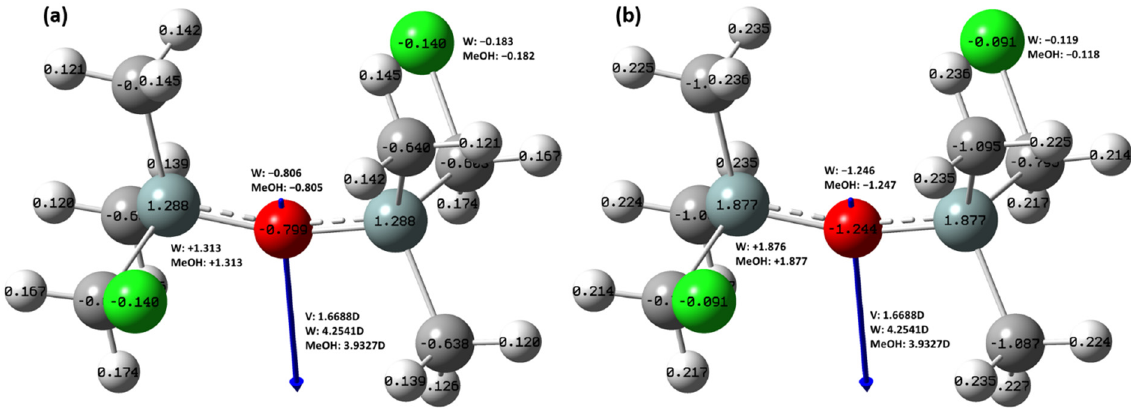
Figure 6. Partial charges for ClMTMDS: ( a ) Mulliken, ( b ) NPA from NBO; implicit solvents: W— water, MeOH—methanol, V—vacuum. W—water, MeOH—methanol,